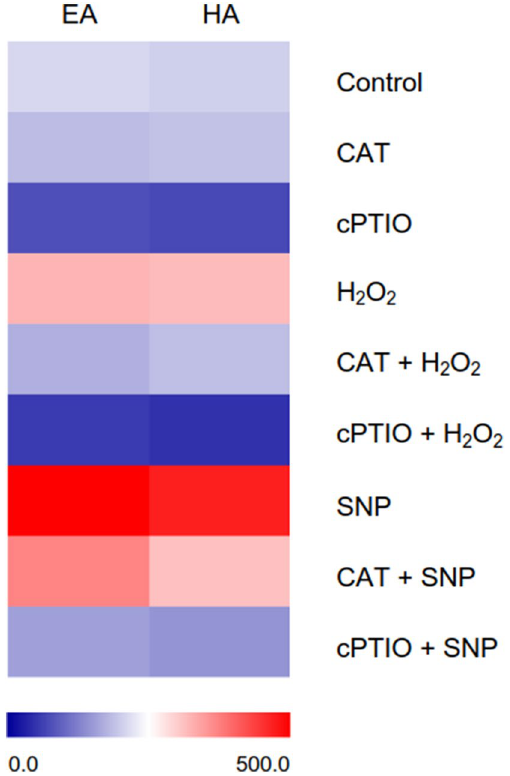
Figure 5. HPLC profiles (UV 460 nm) in different treatments. A color scale indicates the compounds yield, from lowest (blue) to highest (red).